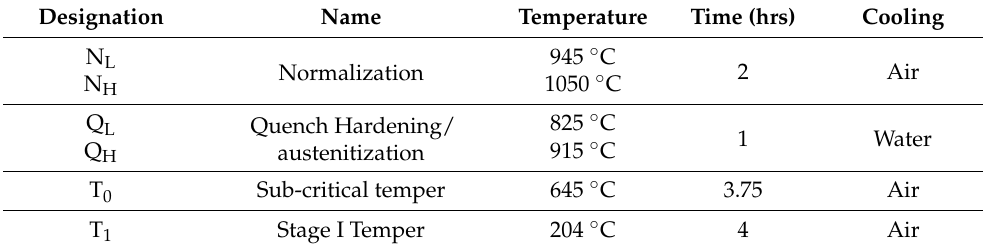
Table 2. Heat treatment designation, temperature and times.